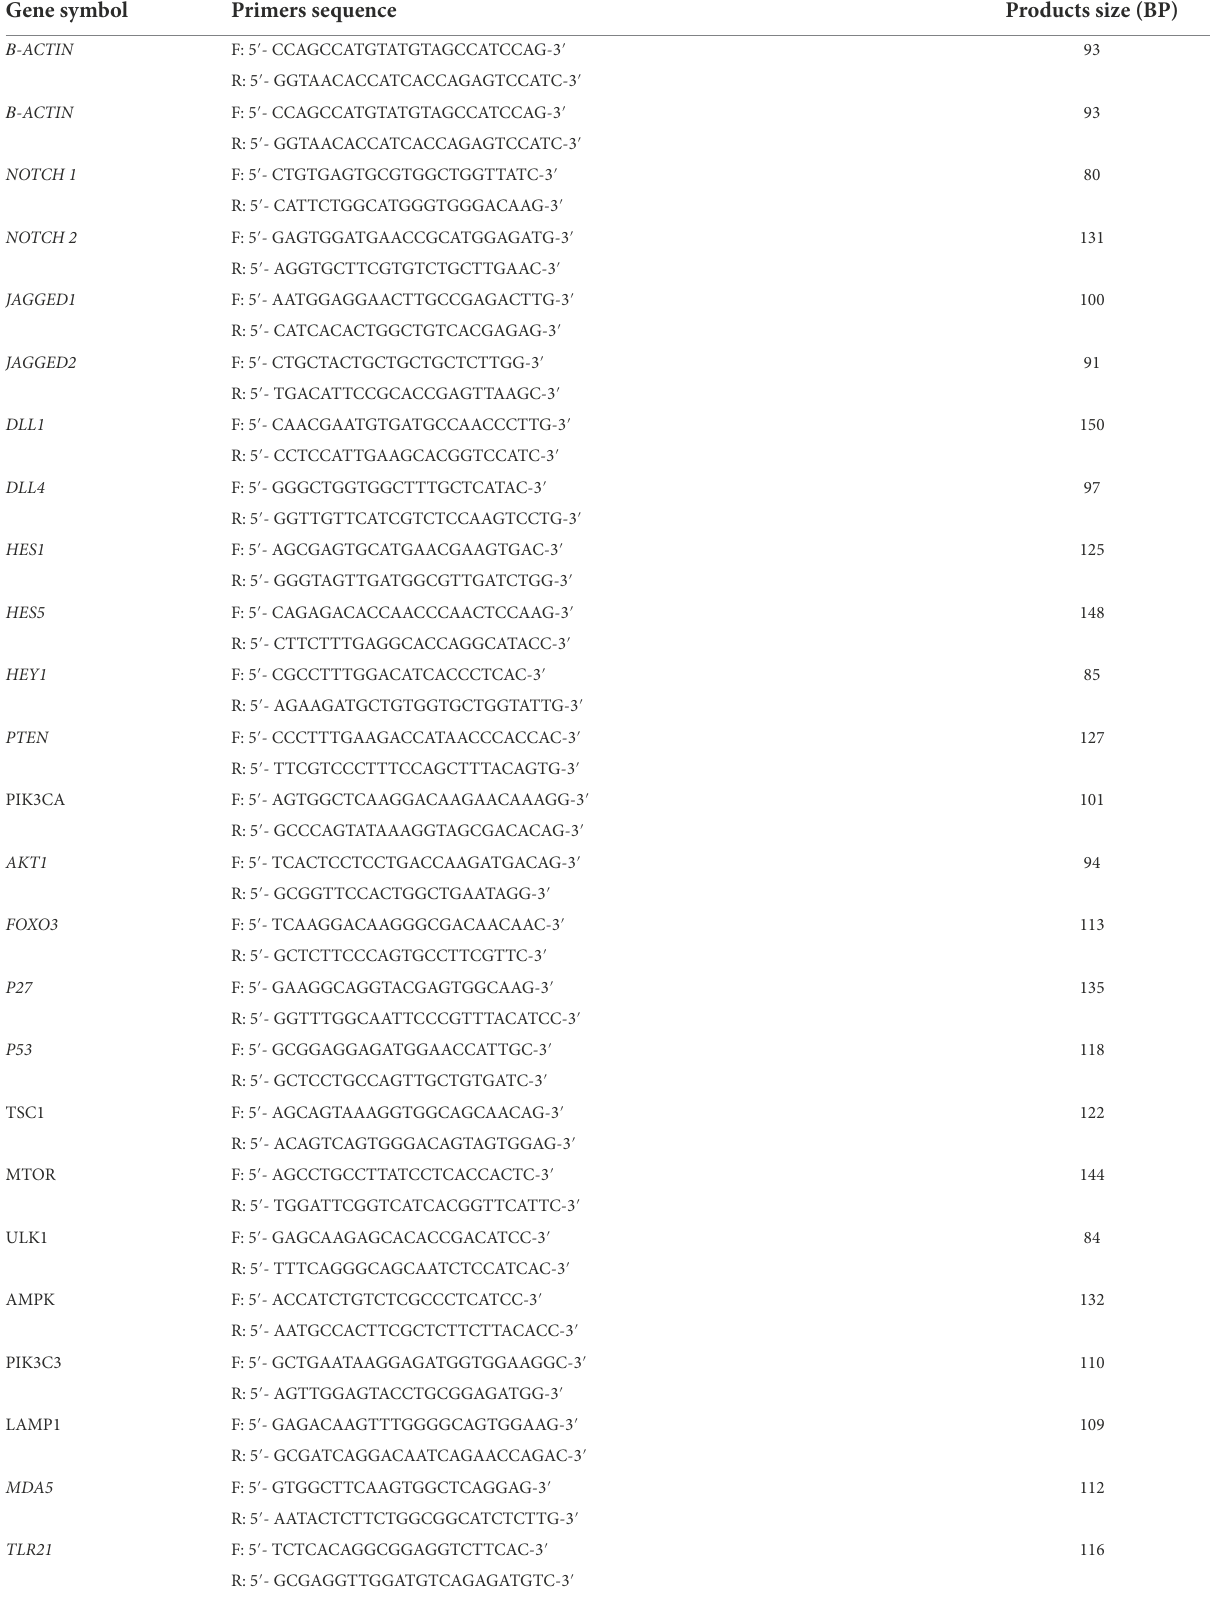
TABLE 1 The primers used in the present